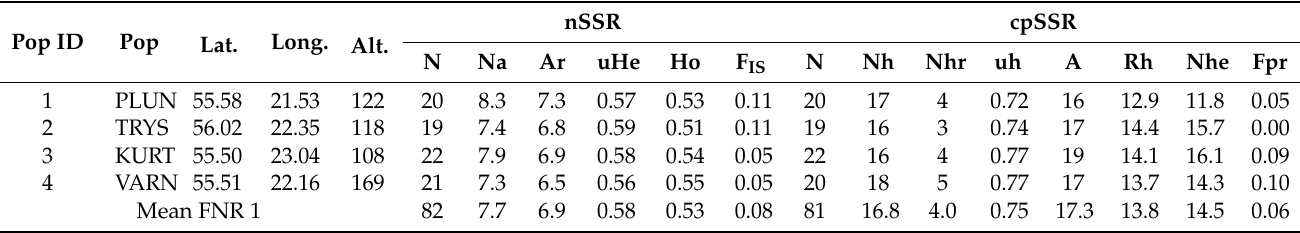
Table 3. The within-population genetic diversity parameters estimated for 12 nSSR loci and 3 cpSSR loci of the pt series. N is the sample size, Na is allele number, Ar is allelic richness (based on 17 individuals), He and Ho are expected and observed heterozygosity, respectively, and F IS inbreeding coefficient. For cpSSR: Nh—number of different alleles, Nhr—number of rare alleles (freq. < 0.05), uh—unbiased genetic diversity (He for haplotype data), A—number of different haplotypes, Rh—haplotypic richness, Nhe—effective haplotype number, Fpr—frequency of population private haplotypes, FNR—forest natural region where mean and standard error is given.